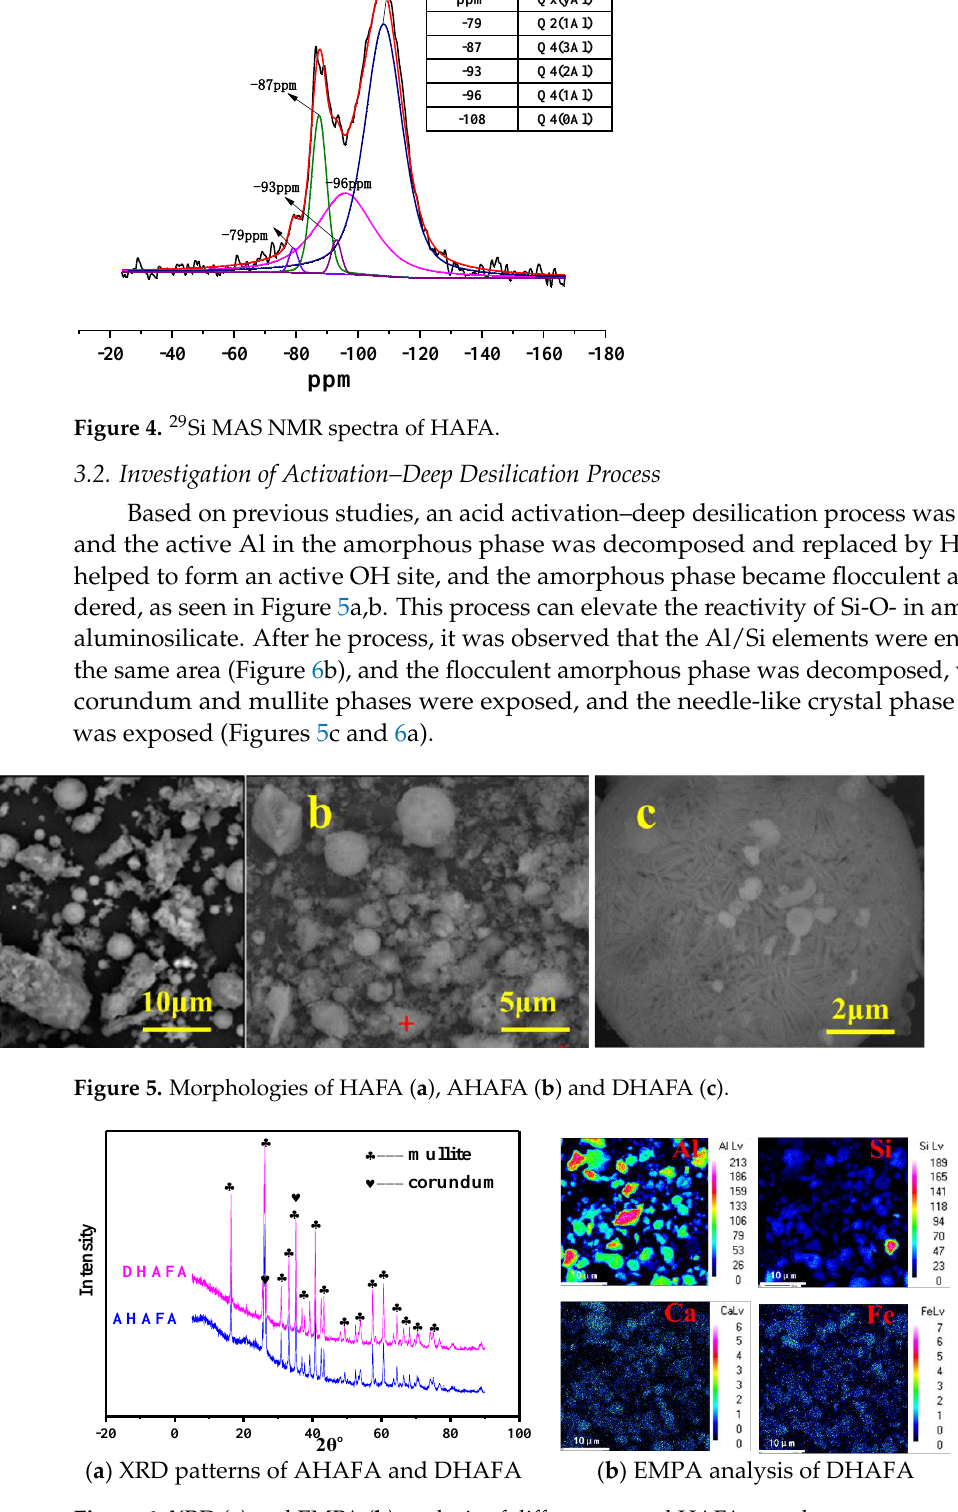
Figure 3. SEM images of HAFA ( a ) and EDX analysis of amorphous phase ( b ) and mullite phase ( c ). Figure 4 shows that the amorphous silicate was in the form of